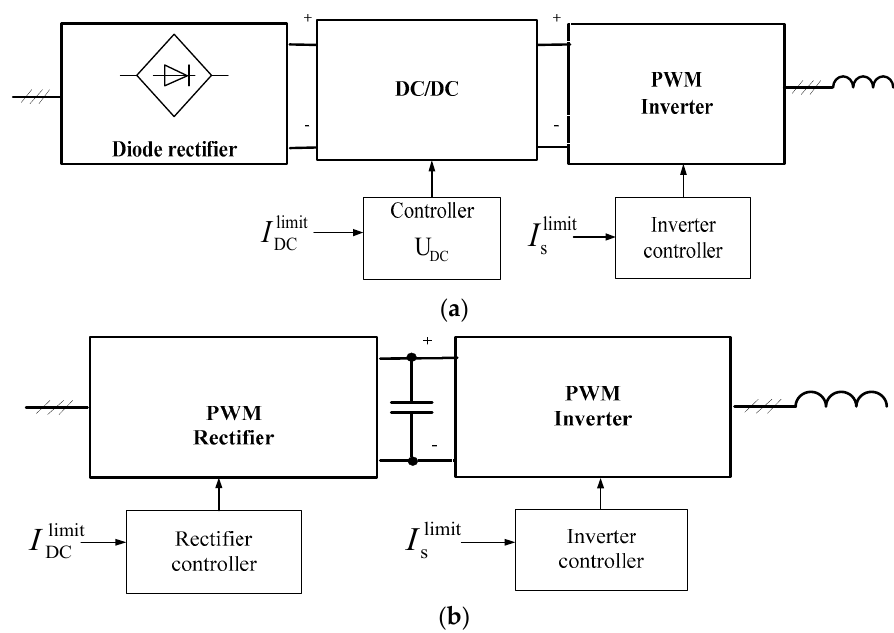
Figure 4. Block diagram of a Power Electronic Unit (PEU) with: ( a ) a diode rectifier and DC/DC booster; and ( b ) a PWM rectifier.